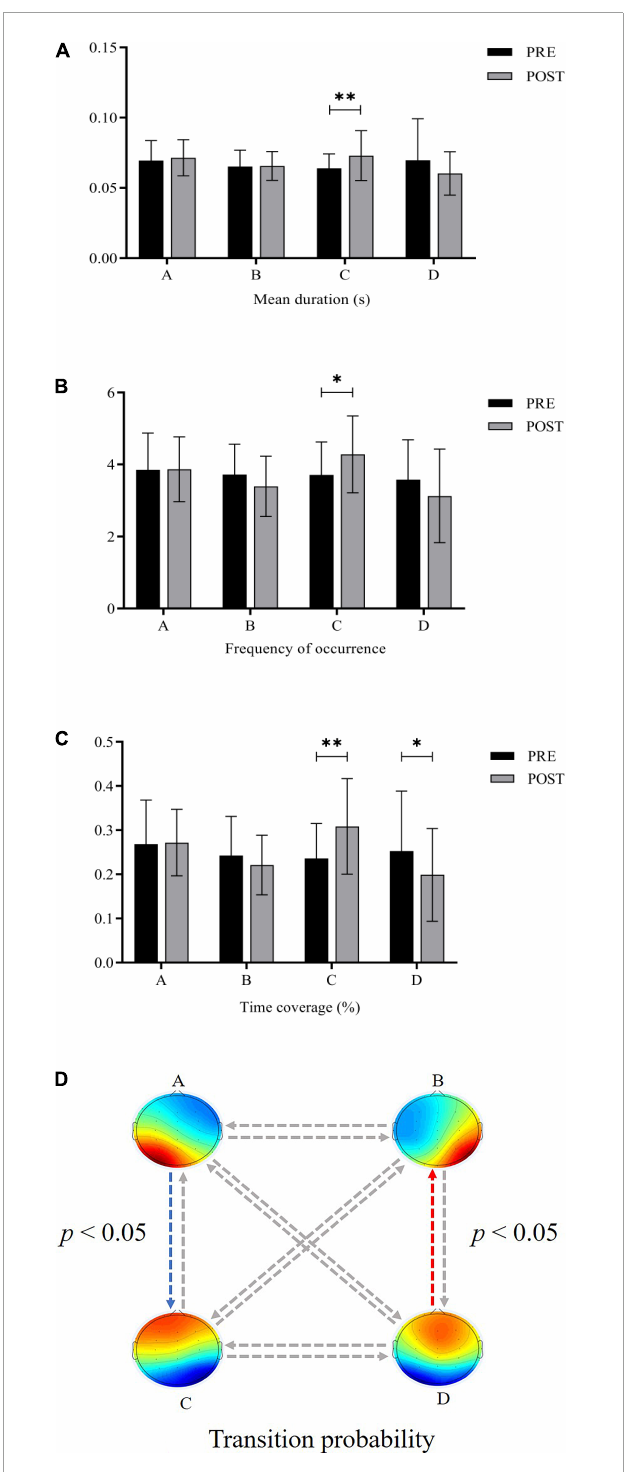
FIGURE1 Comparison of microstate parameters before and after exhaustive exercise (A) duration (B) occurrence (C) time coverage (D) transition probability ( ∗ : p < 0.05; ∗∗ : p < 0.01; blue arrow: increase; red arrow: